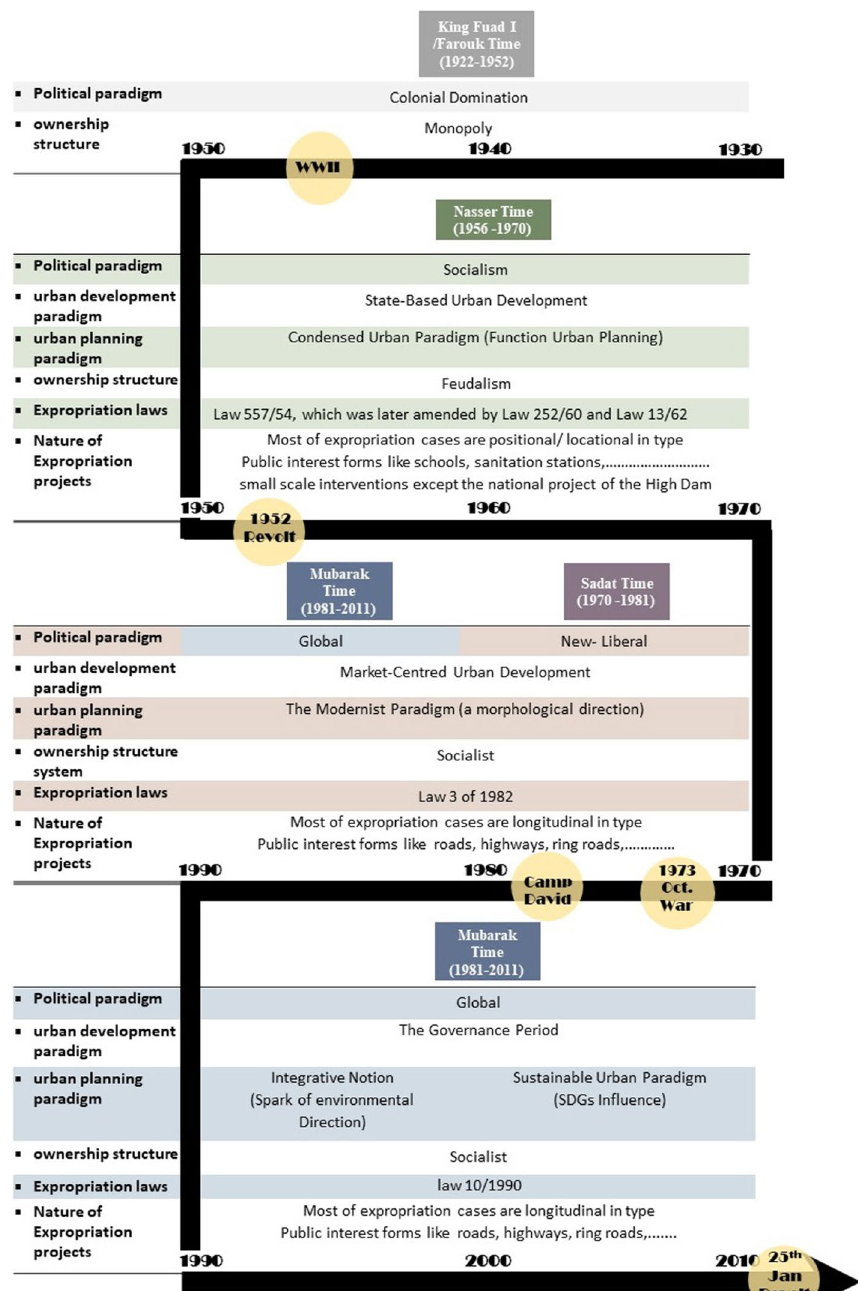
Fig. 3 Timeline of expropriration analytical framework of Egypt from Nasser’s to Mubarak Time